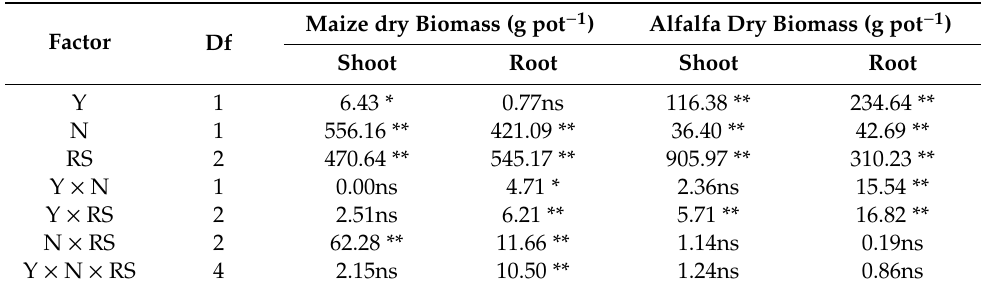
Table 1. Results of the repeated measures ANOVA for the dry biomass of maize and alfalfa, with the nitrogen level (N) and the root separation method (RS) as the independent variables and year (Y) as the repeated measure. ×